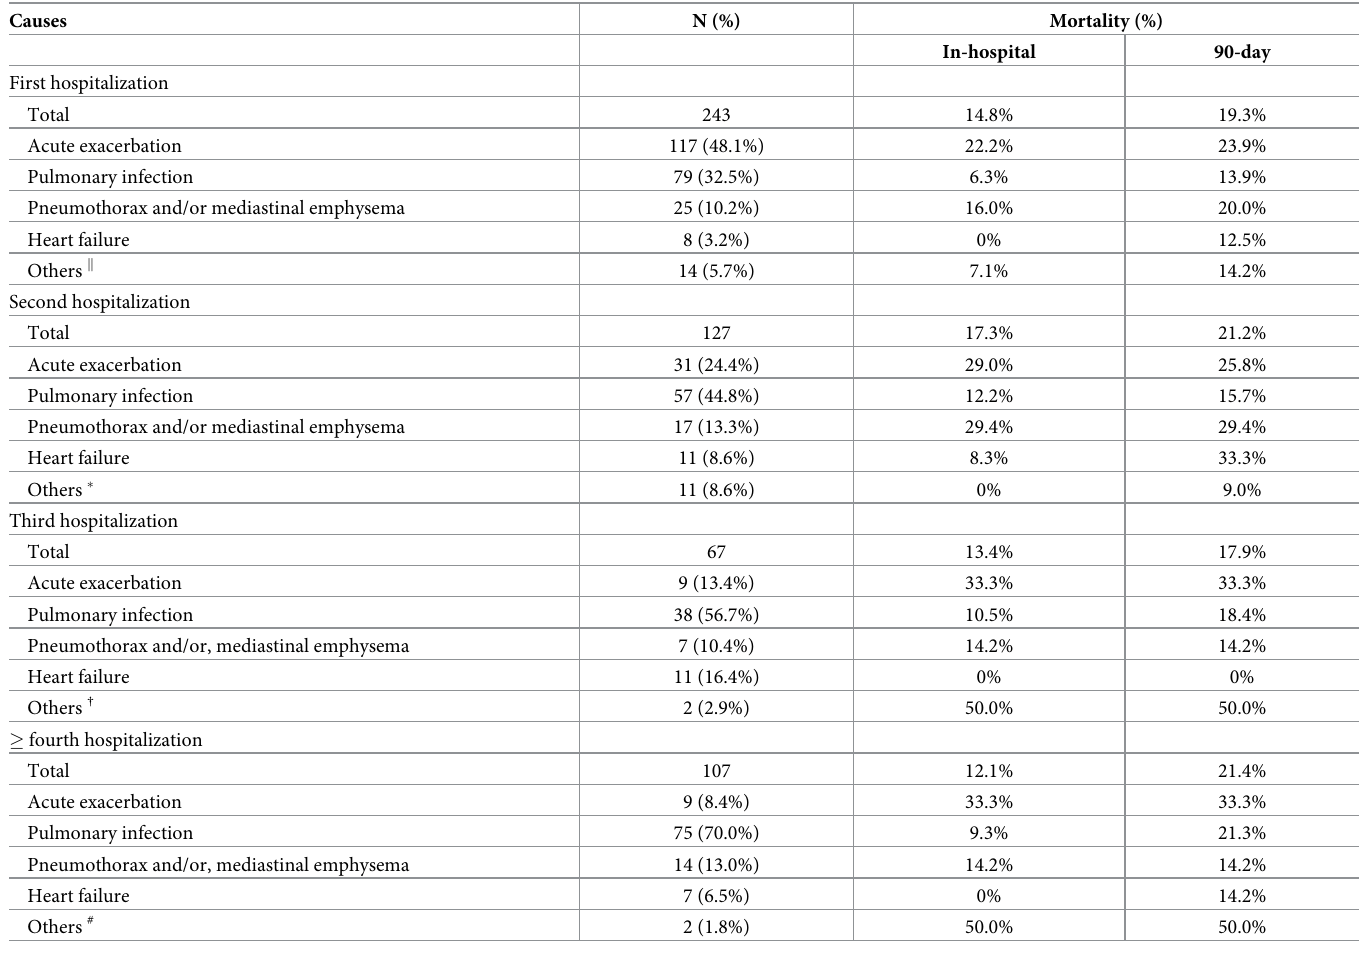
Table 3. Causes of the hospitalization and mortality of each hospitalization. Causes N (%)